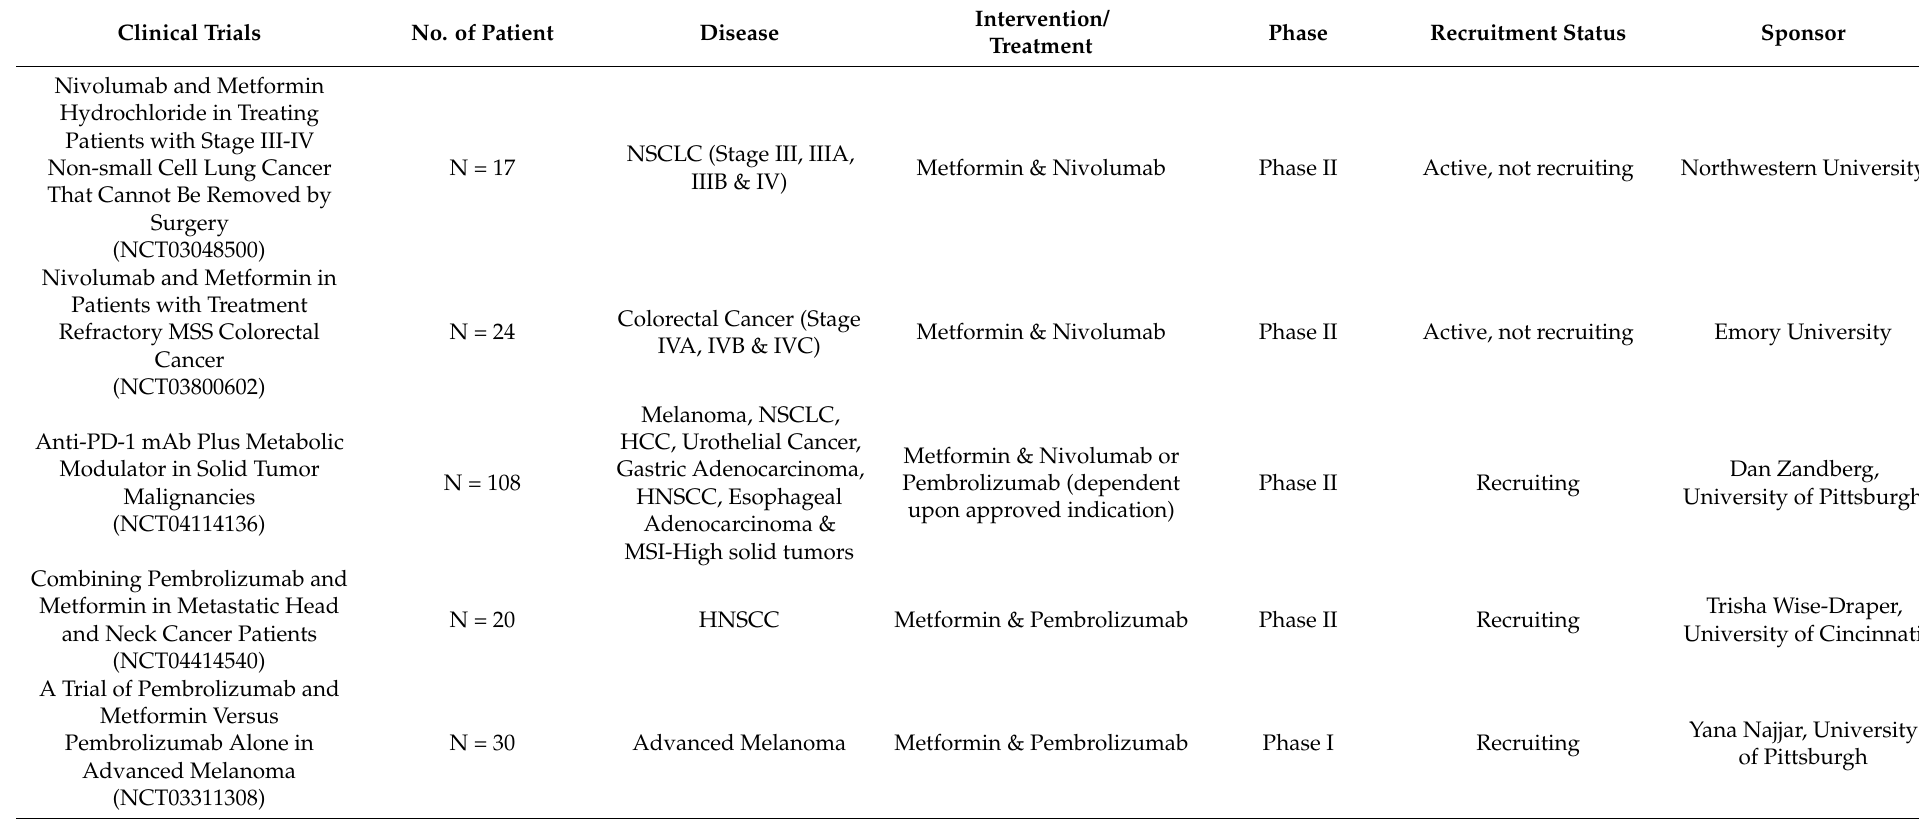
Table 1. Information about the clinical trials on the combined treatment of Metformin and ICIs from NIH ClinicalTrials.gov. PD-1 inhibitors Nivolumab, Pembrolizumab, and Cemiplimab are on the current list of the FDA-approved agents. However, only the first two of them are being explored in concurrent treatment with the AMPK activator